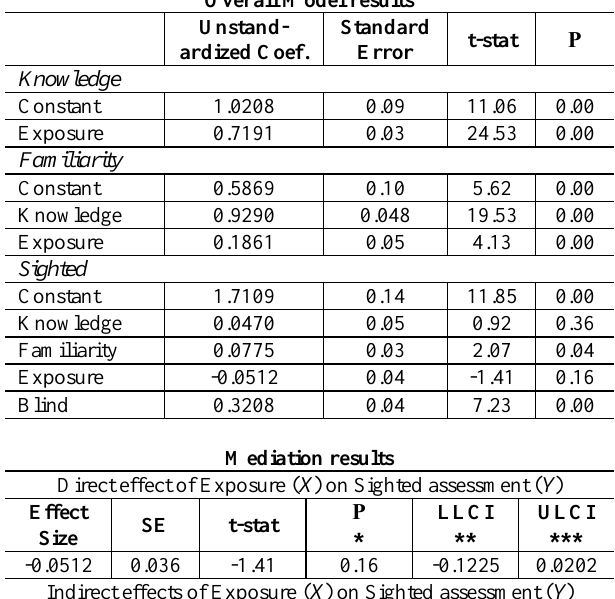
Table 3: Results of mediation